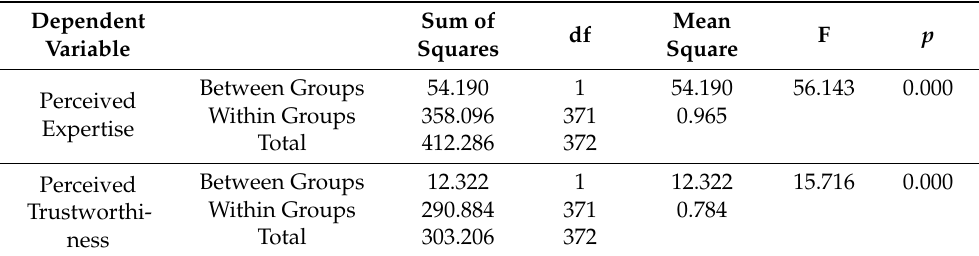
Table 2. Results of One-Way ANOVA tests.